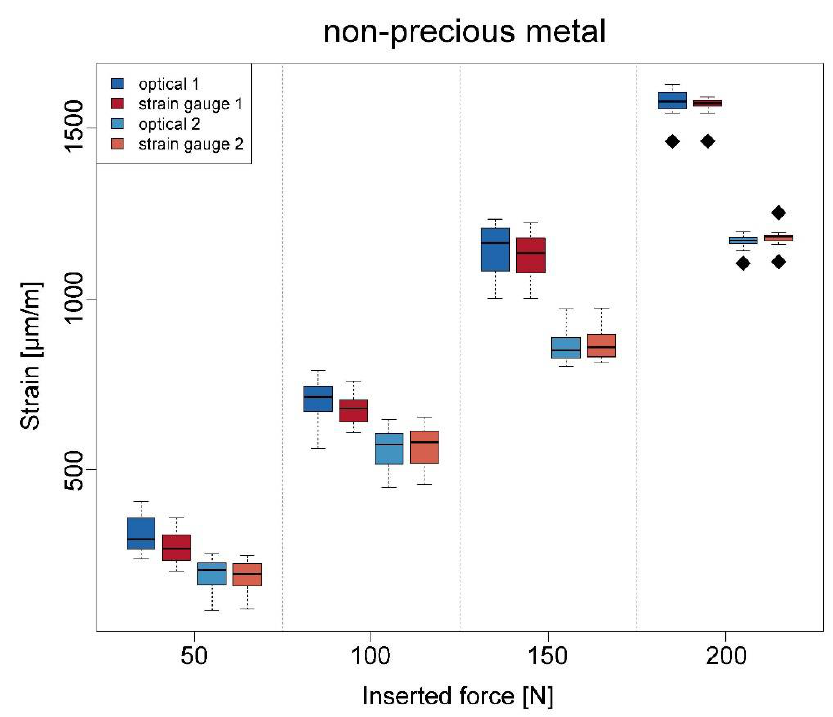
Figure 5. Boxplots regarding the strain at different inserted forces and in the case of the superstructure made of non-precious metal.